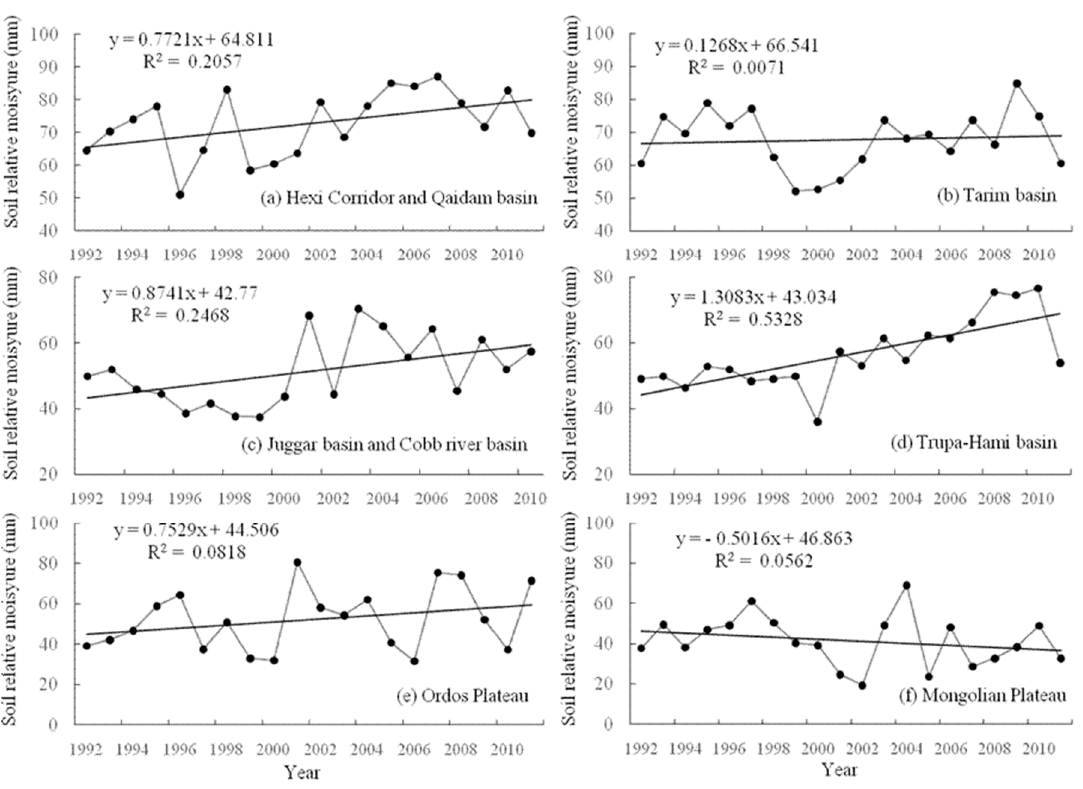
Figure 7. Variation in relative soil moisture in different inland river basins.